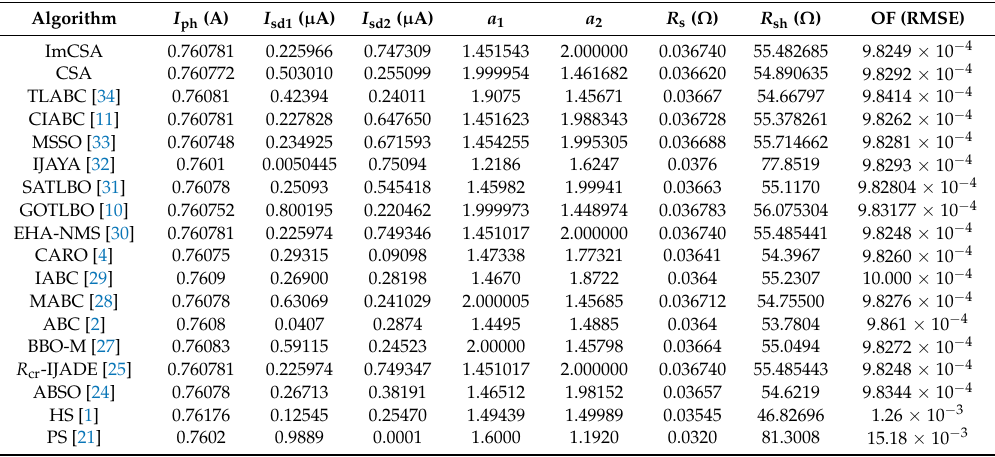
Table 5. Comparison among various parameter estimation algorithms for the DDM of RTC France silicon solar